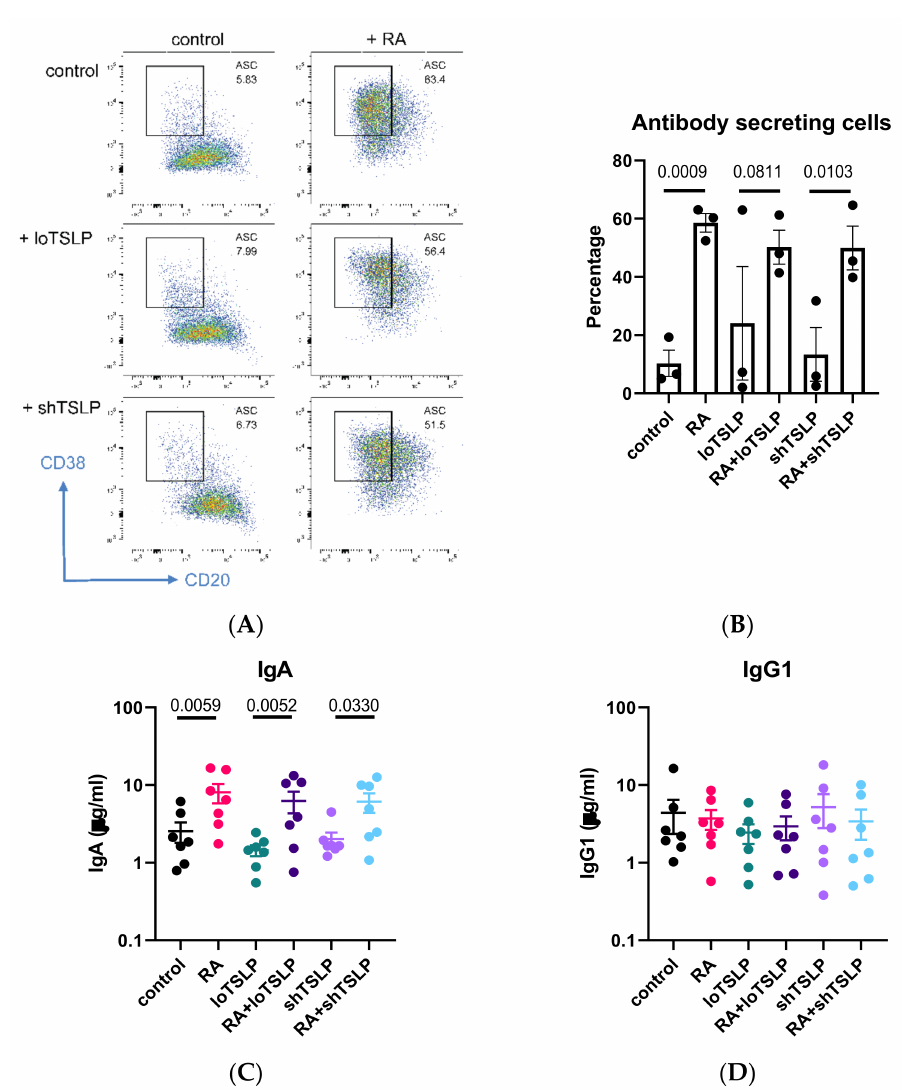
Figure 5. The role of retinoic acid (RA) in inducing secretion of IgA. CD19 B cells were cultured for 7 days and stained for CD20 and CD38 ( A ) in the presence or absence of RA and TSLP ( B ) for 3 donors in a single experiment. B cells were cultured for 11 days and supernatants analyzed for concentrations of IgA ( C ) and IgG1 ( D ) for seven donors in two independent experiments. Graphs show mean and standard error of the mean, and statistical test results are obtained from ANOVA with Sidaks correction for multiple